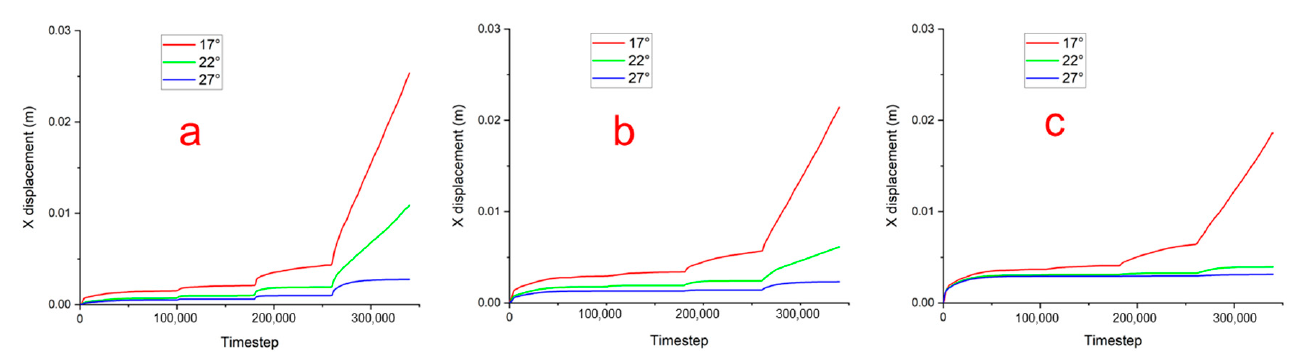
Figure 17. Sensitivity analysis of S0 friction angle by varying from 17 ◦ to 27 ◦ , showing the displace- ment of history points in X direction ( a ) H1, ( b ) H2 and ( c ) H3.